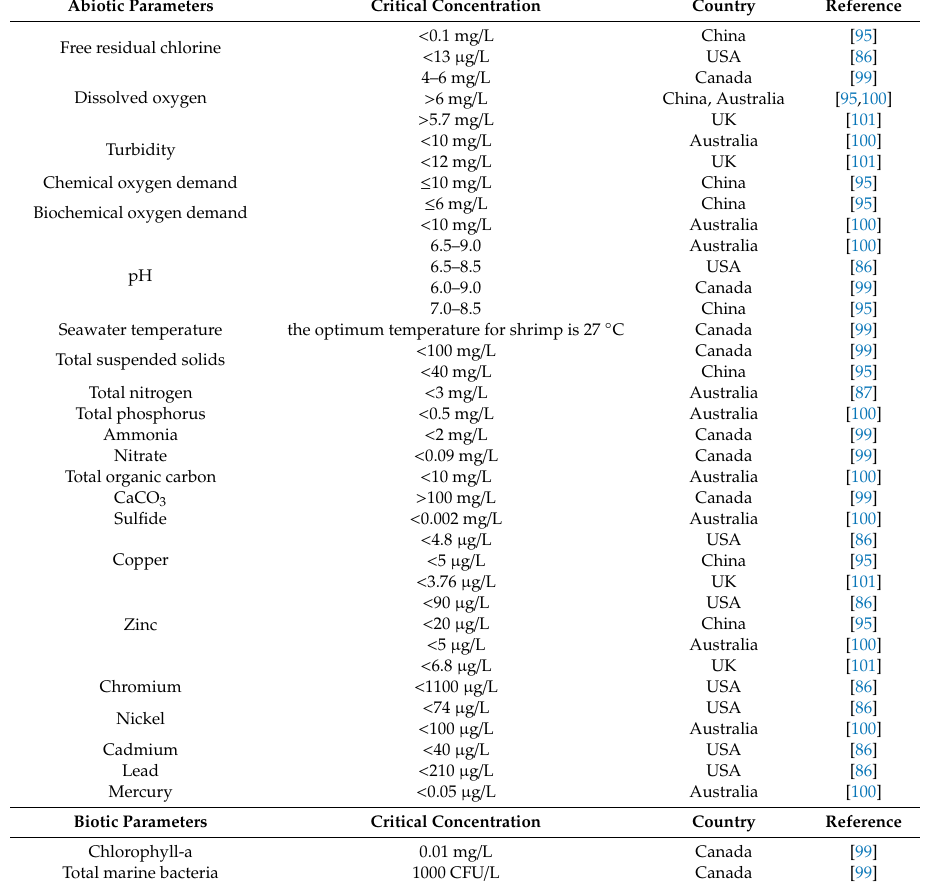
Table 3. Listofabioticandbioticparametersofemissionlimitvalues(ELVs)indifferentcountriesandregions. Abiotic Parameters Critical Concentration